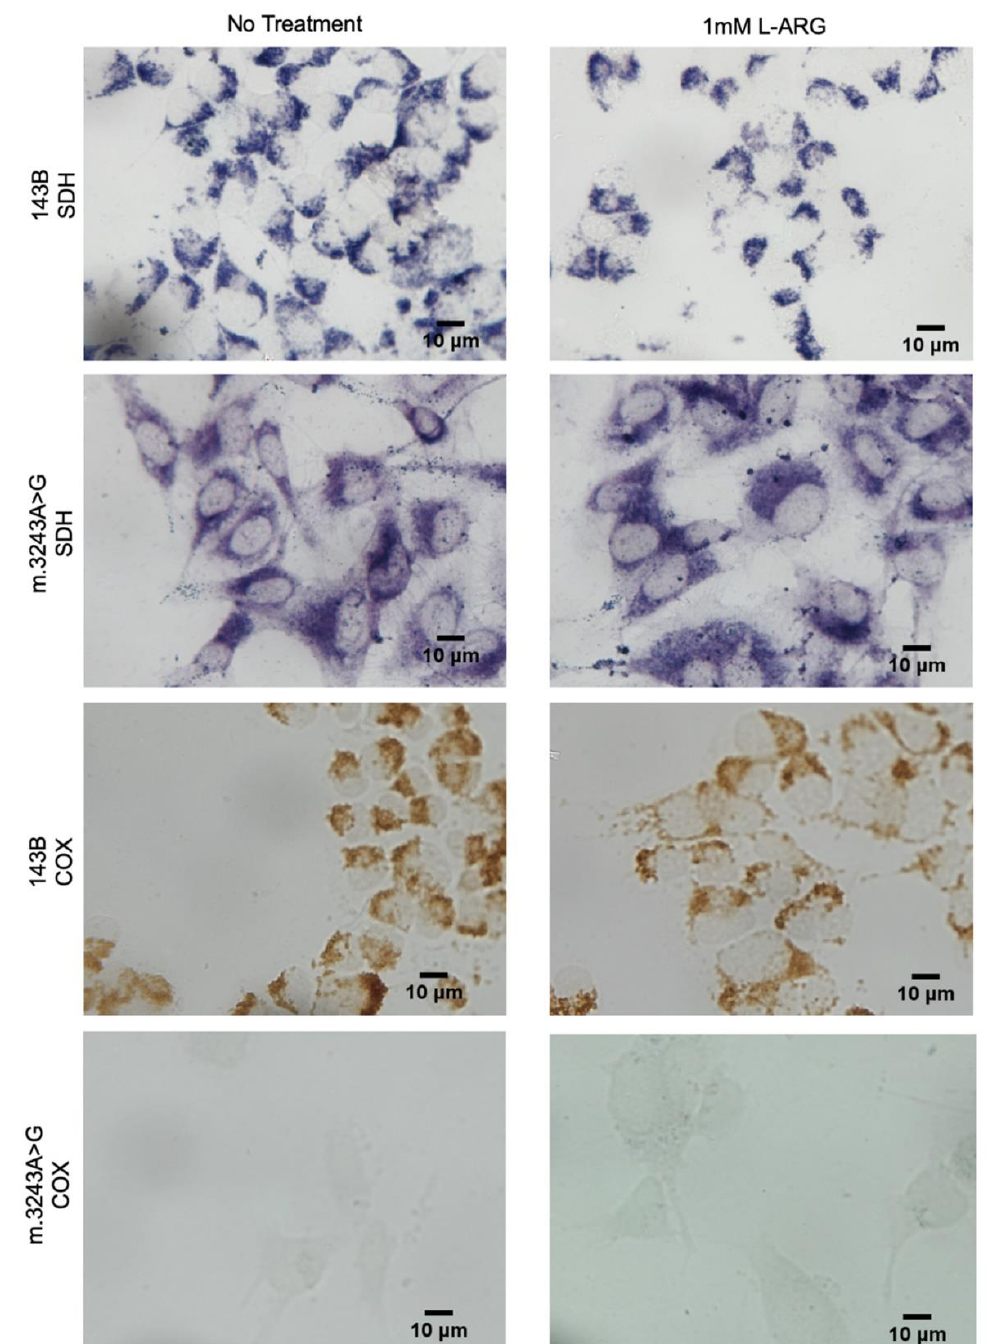
Figure 2. SDH and COX activities by cytochemical staining showed no improvement in COX. 143B cells had preserved SDH and COX activities with and without L-ARG. SDH activity was also preserved in m.3243A>G cells in both conditions, with and without treatment, but had a low COX activity in basal conditions. L-ARG treatment did not modify this pattern of severe COX deficiency, and no cells had COX activity.